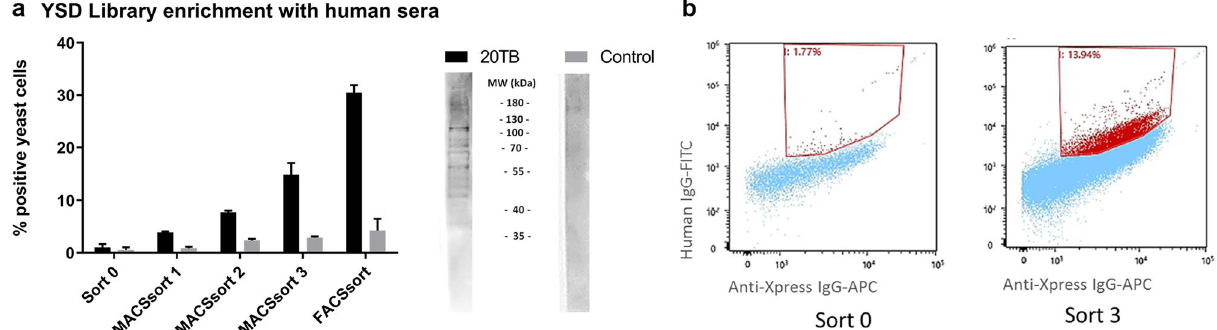
Figure 1. I. ricinus SGP - YSD library enrichment by human sera. ( a ) Effect of library enrichment as determined by FACS, showing the percentage of induction induced Xpress-tag positive yeast cells bound by human IgG. The obtained I. ricinus SGP - YSD was probed with 50 µg/ml IgG from humans with more than 20 reported tick bites per year. (20 TB). First 3 sorting rounds were performed by MACS, followed by one time by FACS as shown in b. Columns depict the mean percentage of Xpress and human IgG positive cells, error bars show the standard error of the mean. Western Blot of 10 µg salivary gland extract from 72 h fed I. ricinus nymph labeled with 20 TB human IgG or control IgG is shown in the legend under each respective IgG. ( b ) FACSsort on MACSsort 3. Sort 0, the initial SGP-YSD library, and MACSort 3 were induced and labeled with 50 µg/ml 20 TB IgG and mouse anti-Xpress IgG followed by anti-human IgG-FITC and anti-mouse IgG-APC. The gate was set on the initial library. Double positive yeast cells were sorted as a whole and as single cell clones for further